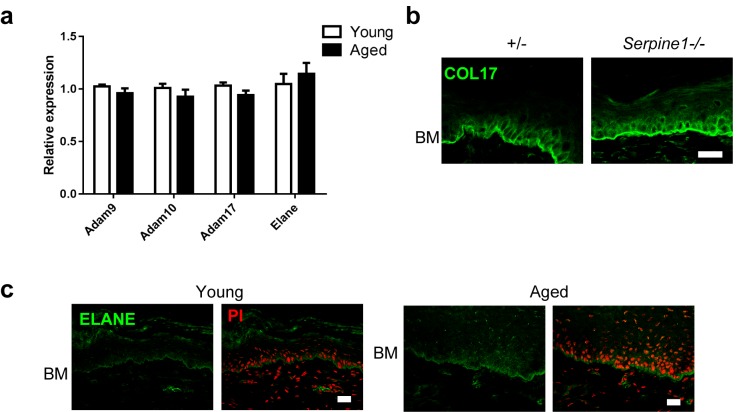
Analysis of epidermal proteases in IFE skin samples from young and aged WT mice.(a) Expression levels from the microarray analysis of genes encoding proteases involved in COL17 digestion and degradation (n = 4). (b) COL17 staining in Serpine1−/− and littermate control mice IFE at 8 weeks (representative images from four mice). The antibody against the juxtamembranous NC16A domain of COL17 was used. (c) ELANE labeling of young and aged IFE (representative images from five mice). Scale bar: 20 μm.